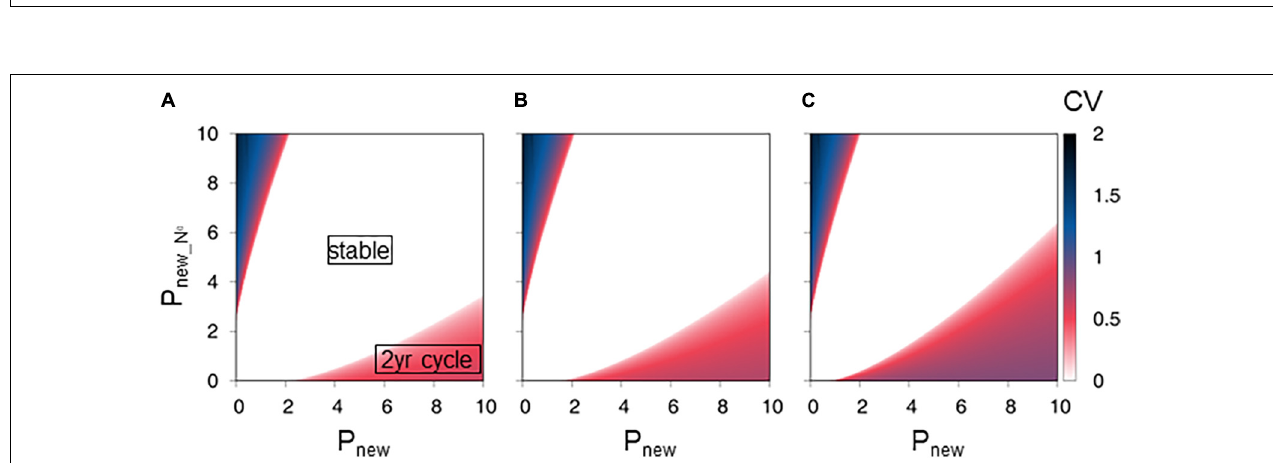
FIGURE 6 | Effect of loss of belowground carbon storage on new shoot production. The figures show the final state coefficient of variation (CV) value from a series of r values of (A) 0.0, (B) 0.2, and (C) 0.6. The color gradation bars represent the CV.